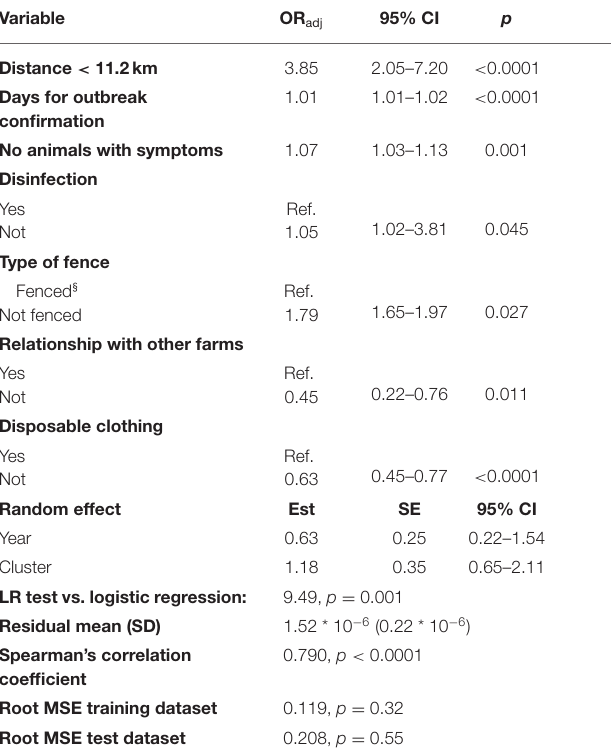
LR test vs. logistic